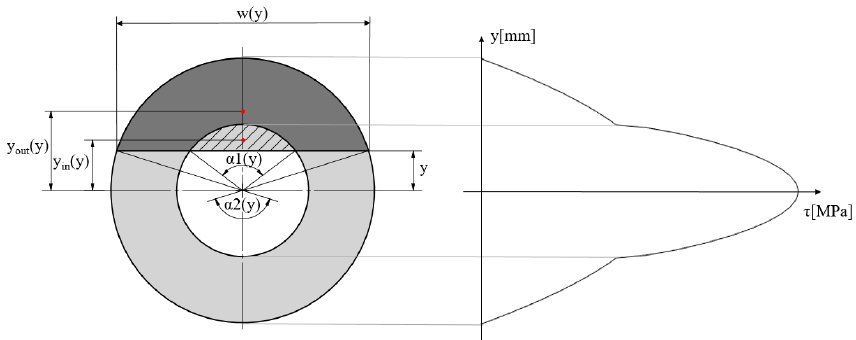
Figure 10. Geometry for shear stress calculation.